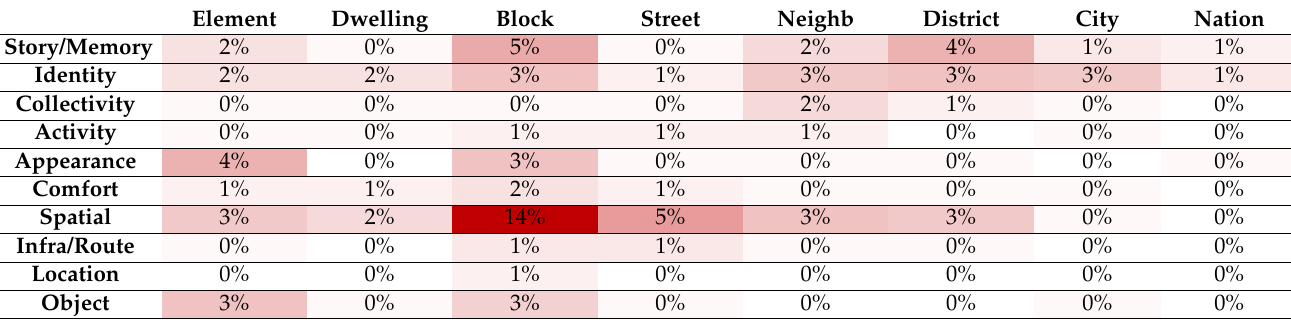
Table A7. Makers: four